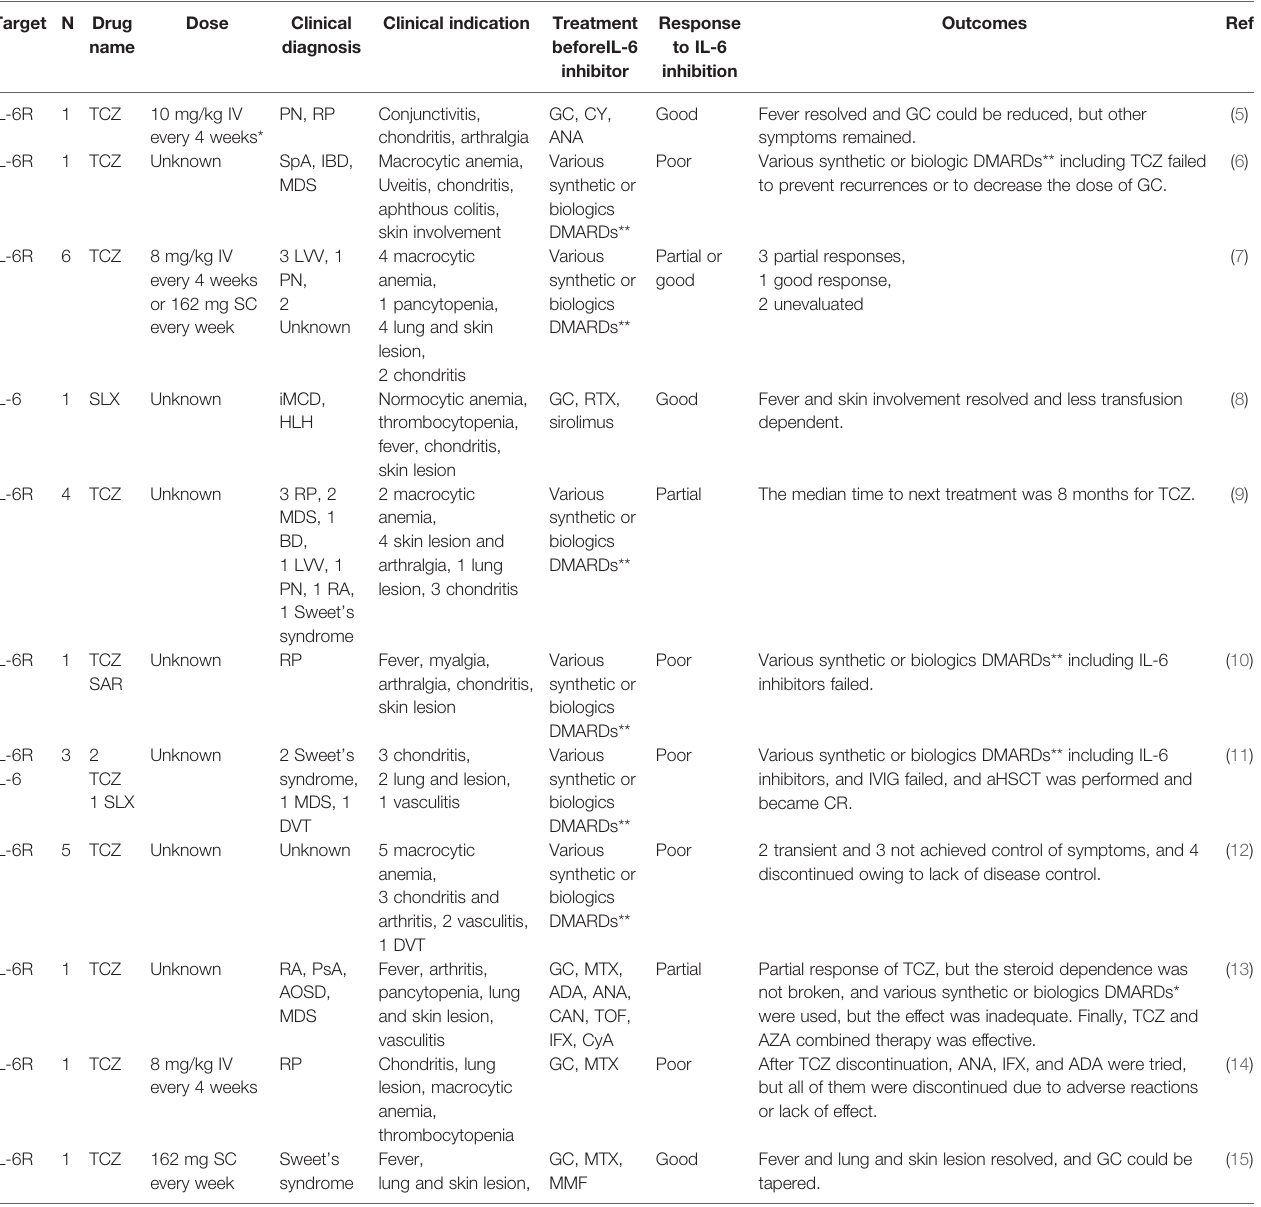
TABLE 3 | Anti-IL-6 inhibitors used in treating VEXAS syndrome. Target N Drug